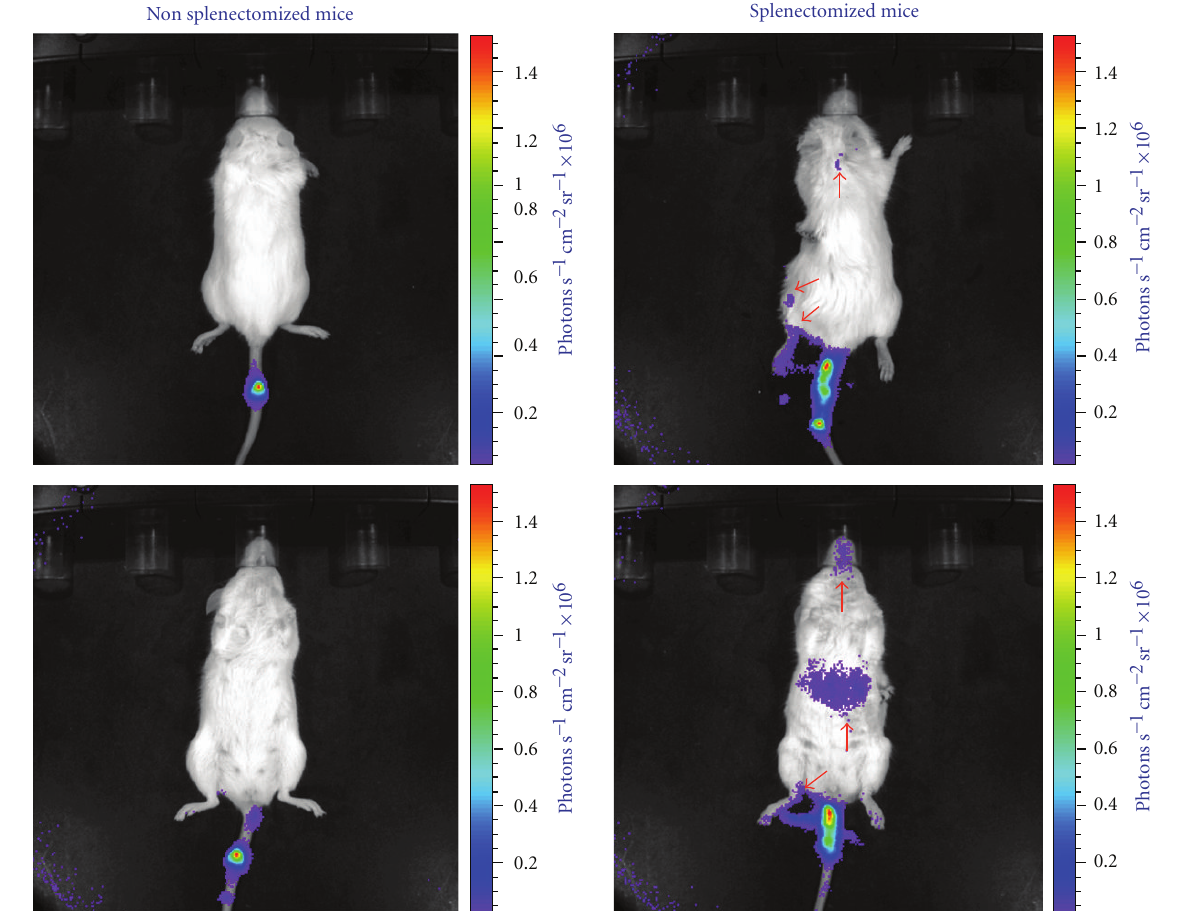
Figure 6: Significant level of extGLuc signal is detectable in splenectomized mice 24 hrs after transfusion. Bioluminescent imaging of nonsplenectomized (left panels) and splenectomized (right panels) mice 24 hrs after injection with extGLuc + EBs, as indicated. Dorsal and ventral imaging is presented in the top and bottom panels, respectively. In intact mice, the bioluminescent signal was virtually undetectable other than at the site of injection (the tail). In the splenectomized mice, significant signal levels were observed in limbs (lower extremity), skull (indicating marrow localization), and abdomen (indicating liver localization because the spleen had been removed). Arrows indicate the positive signal. Data are representative of those observed with 4 mice per experimental